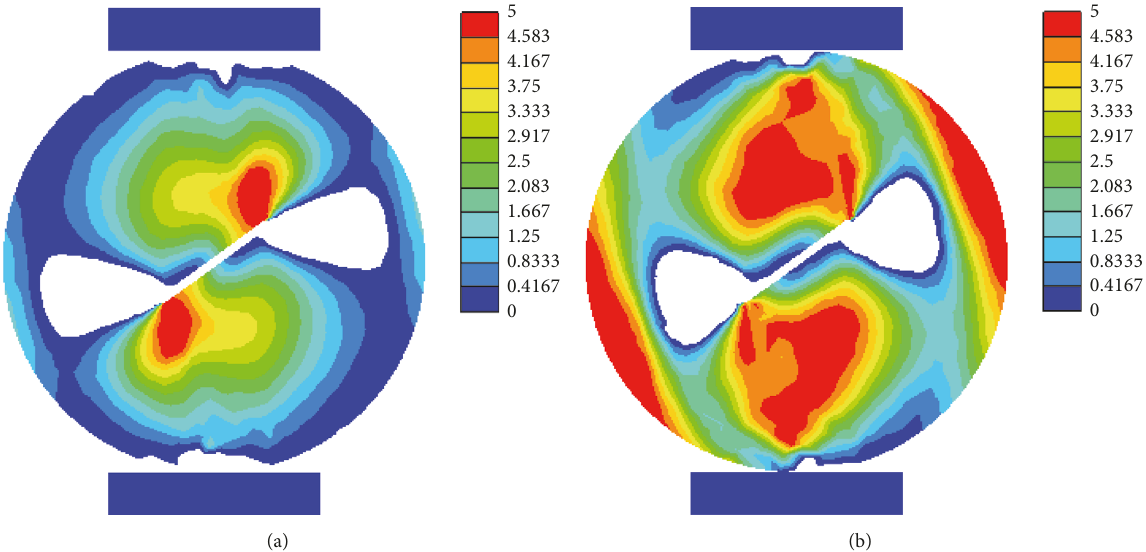
Figure 14: Distribution of the minimum principal stress (unit: MPa) for 𝛽 = 54 ∘ and 2𝑎 = 15 mm: (a) stage before wing cracks are inserted; (b) stage before secondary cracks are inserted.